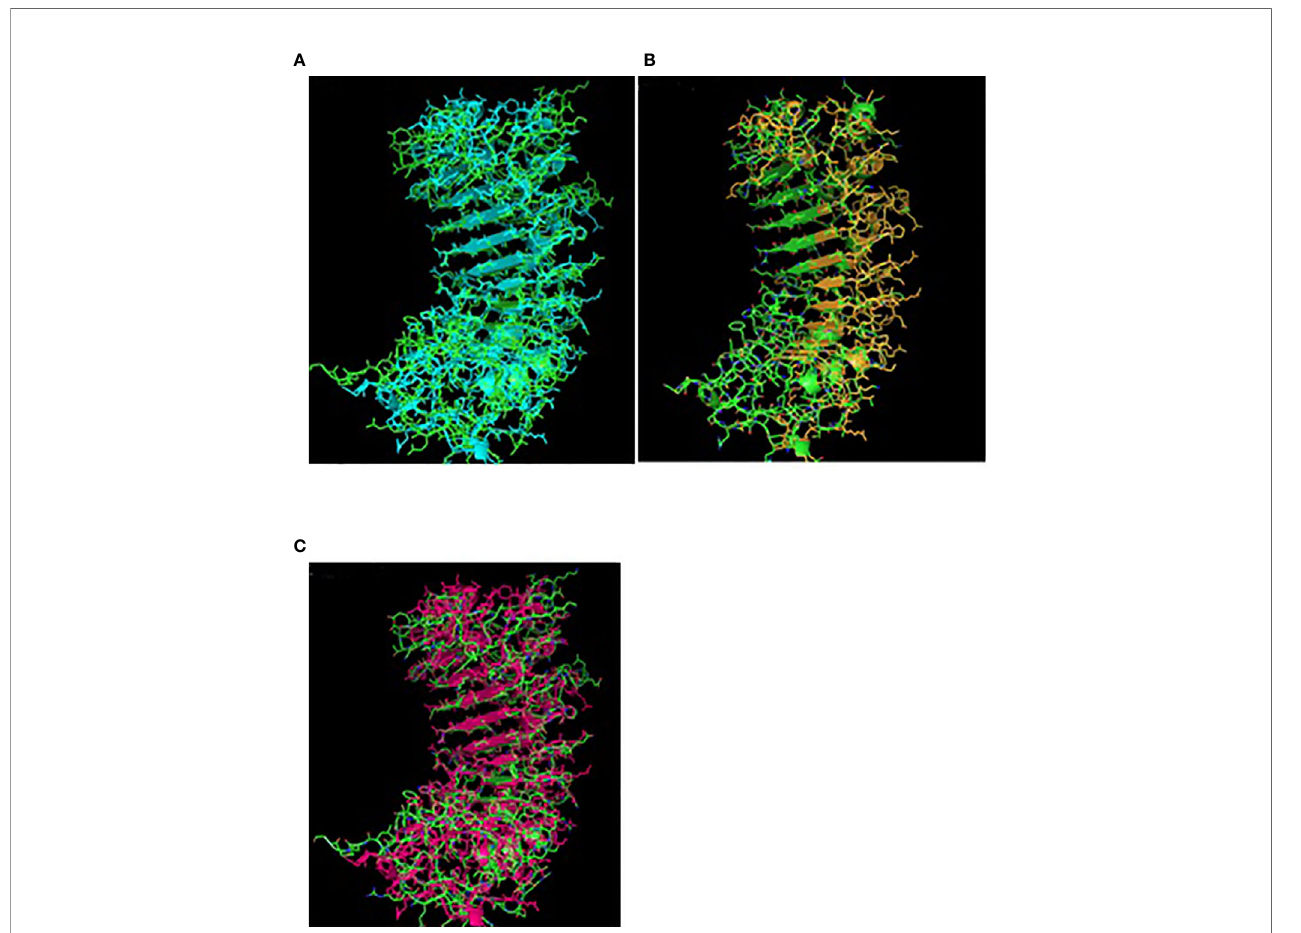
FIGURE 4 | TM alignment of 3D structure of sheep with other ruminants. (A) TM alignment of the 3D structure of sheep and goat CD14 molecules. Green, Sheep CD14 molecule, Cyan, Goat CD14 molecule. (B) TM alignment of the 3D structure of sheep and cattle CD14 molecules. Green, Sheep CD14 molecule, Orange, Cattle CD14 molecule. (C) TM alignment of the 3D structure of sheep and buffalo CD14 molecules; Green, Sheep CD14 molecule; Pink, Buffalo CD14